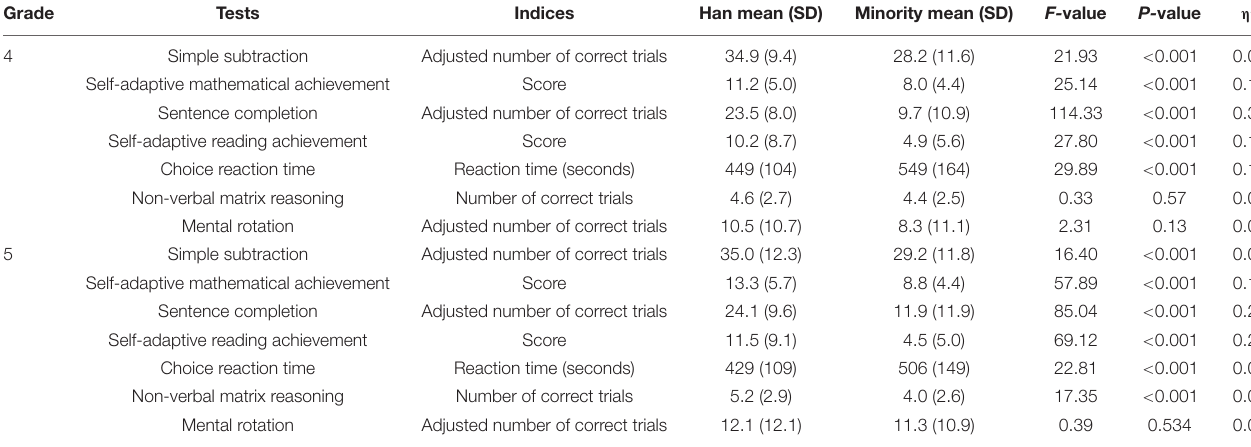
TABLE 1 | Descriptive statistics for all the measures used in the study.